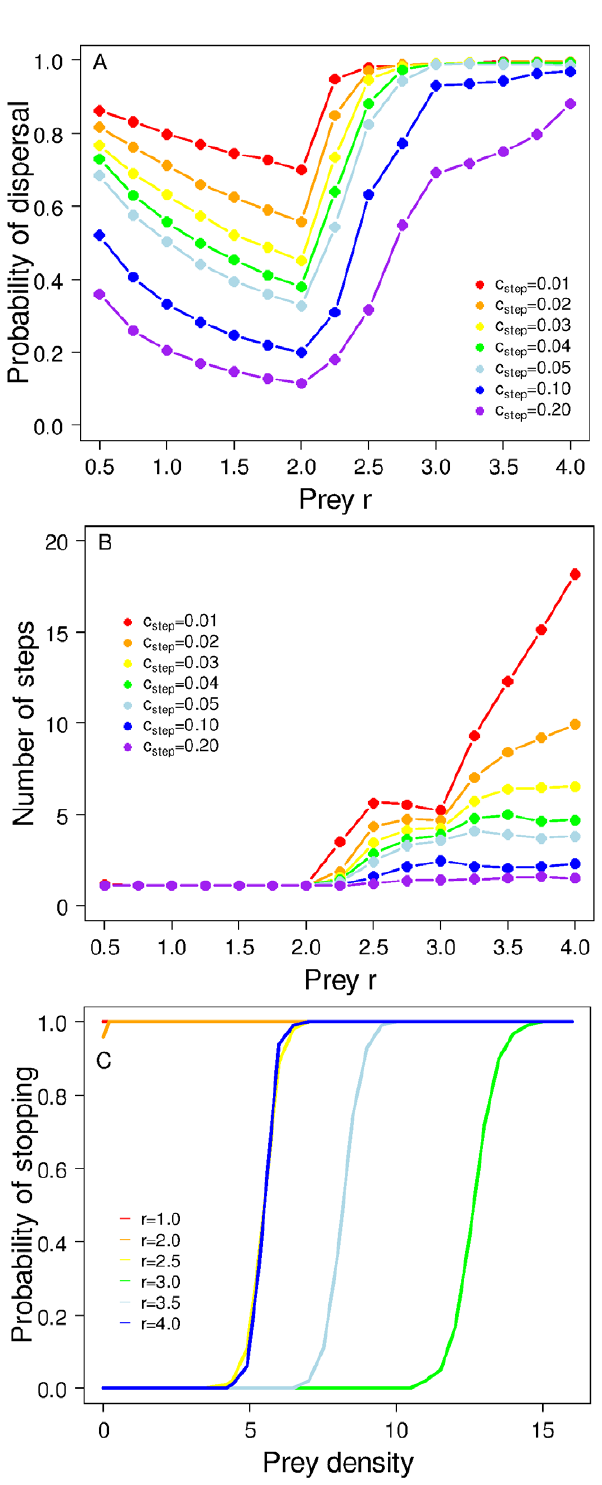
Figure 2. Evolution of a more complex predator dispersal strategy. A qualitatively similar response of dispersal to varying prey r is observed when predators can take multiple steps and evolve a stopping rule dependent on prey density. (A) Dispersal probability at seven levels of predator per-step dispersal mortality c step . (B) The mean number of steps taken by predators across the same range of r and c step as in (A). The number of steps taken by predators is a function of the rules that they have evolved, together with the spatio-temporal characteristics of the environment. (C) The mean stopping rules